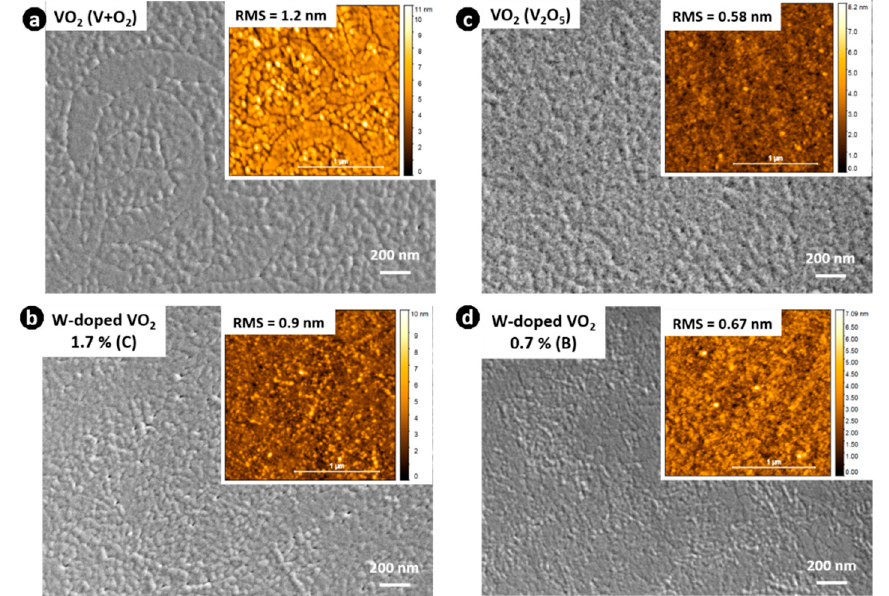
Figure 8. Top-view SEM micrographs of the obtained thin films after rapid thermal annealing ( a ) VO 2 thin film obtained from V+O 2 . ( b ) W-doped VO 2 (1.7 at. % W, sample C). ( c ) VO 2 thin film obtained from V 2 O 5 . ( d ) W-doped VO 2 thin film (0.7 at. % W, sample B). The inserts correspond to the AFM